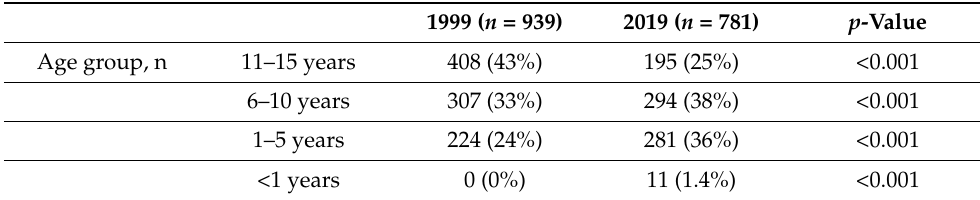
Table 1. Number of fractures broken down by age